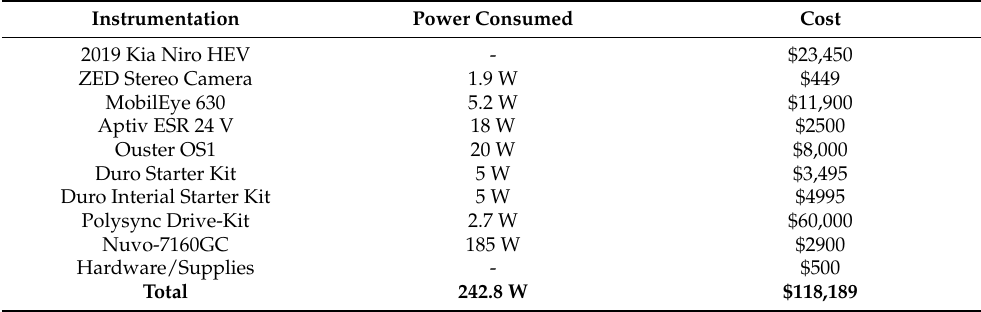
Table 2. The total cost of the sensors and hardware. (-) indicates that power was not considered. * The costs used were all found via internet search engines (based on end of 2019